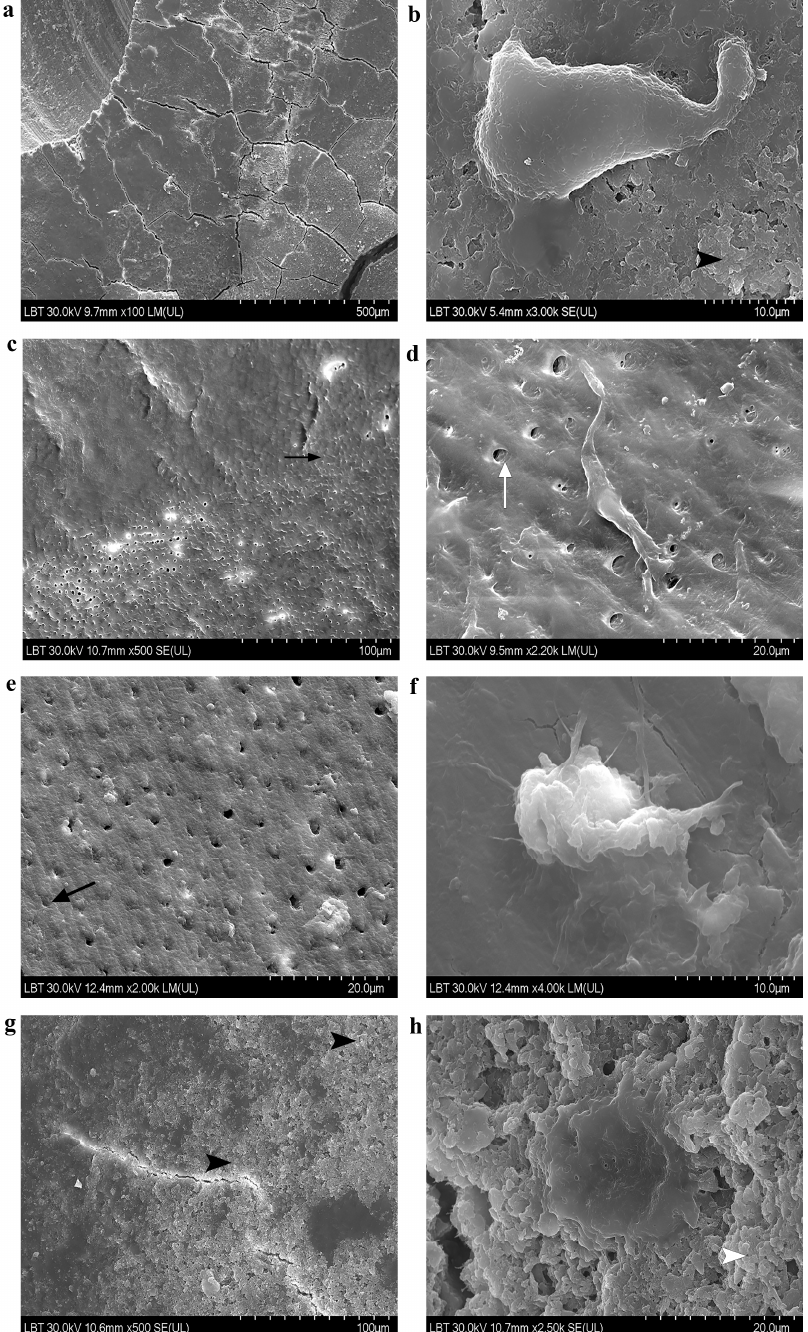
Figure 4. SEM observed samples. ( a ) Continuous smear layer on a instrumented root sample (100×); ( b ) elongate cell, well-attached through pseudopods on a rough smear-layer covered sample after subgingival instrumentation (3000×); ( c ) transversally sectioned dentin tubuli partly obstructed by a continuous smooth smear layer (upper part) on a HI-treated and instrumented sample (500×); ( d ) fusiform well-attached cell through long lamellipodia and dentin tubuli of 3-4 μ m on a HI-treated and instrumented sample (2200×); ( e ) relative smooth smear layer surface partially obstructing dentin tubuli of a PS-treated and instrumented sample (2000×); ( f ) attached cell through filopodia on a relatively smooth PS-treated and instrumented sample (4000×); ( g ) rough surface due to im- portant deposits of a PF-treated and instrumented sample (500×); ( h ) beautiful flattened adherent cell through short lamellipodia on a very rough PF-treated and instrumented sample (2500×) . HI = HybenX; PS = Perisolv; PF = Perioflush. Black arrowhead = rough smear-layer; white arrowhead =